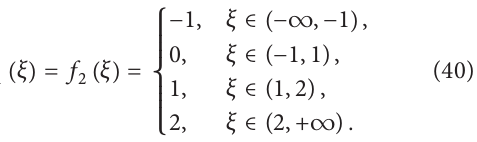
𝐵 = (−4.5987, 5.5989, −4.8991) 3